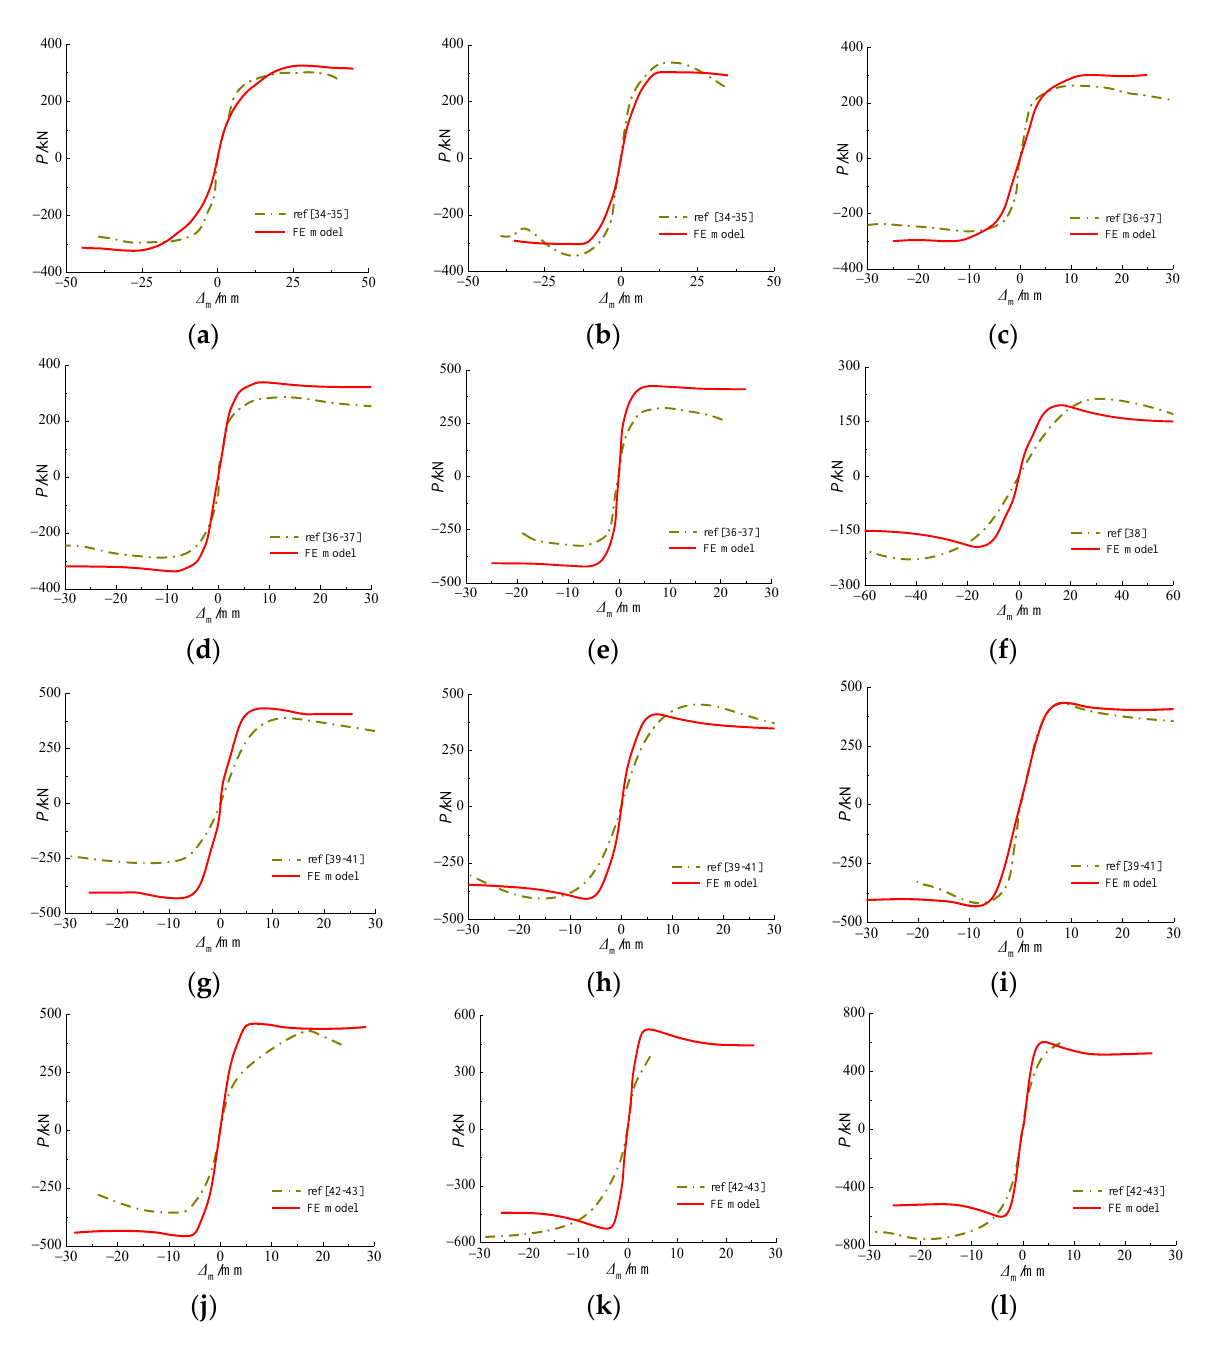
Figure 10. Comparison of skeleton curve between test specimen and FE model under cyclic loading at ambient temperature. ( a ) STRC-60-1.5-4; ( b ) STRC-60-1.5-6; ( c ) STRC-70-1.5-4; ( d ) STRC-70-1.5-5; ( e ) STRC-70-1.5-6; ( f ) FGZ4; ( g ) A1; ( h ) A2; ( i ) A3; ( j ) RS-4L; ( k ) RS-6M; ( l ) RS-10H.